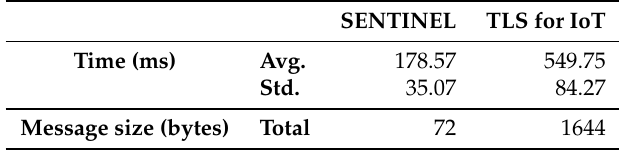
Table 4. Evaluation results of drone authentication